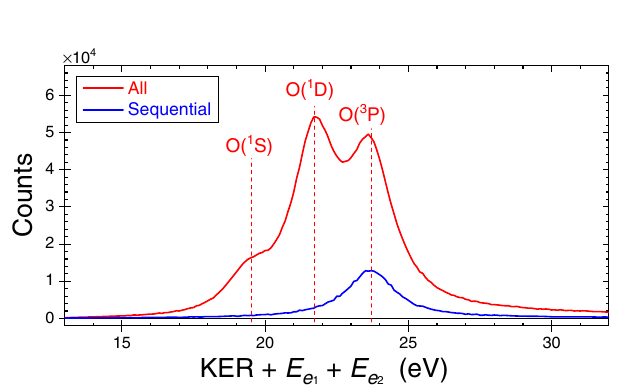
Fig. 3 | Normalized angular momentum distributions. These P ( J ) distributions ( Σ j P ( j )=1) are computed for the a b 1 Σ + and b a 1 Δ states of OD + populated during D 2 O 2+ fragmentation (see text). Calculated angular momentum — KER OD tion mapsfor the c b 1 Σ + and d a 1 Δ states. The linesinpanels c and d represent the modi fi cation of the appearance window in Fig. 1b for nonzero rotational angular